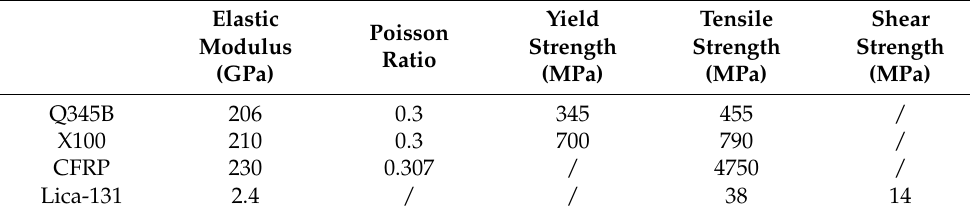
Table 2. Test Configuration and Specimen